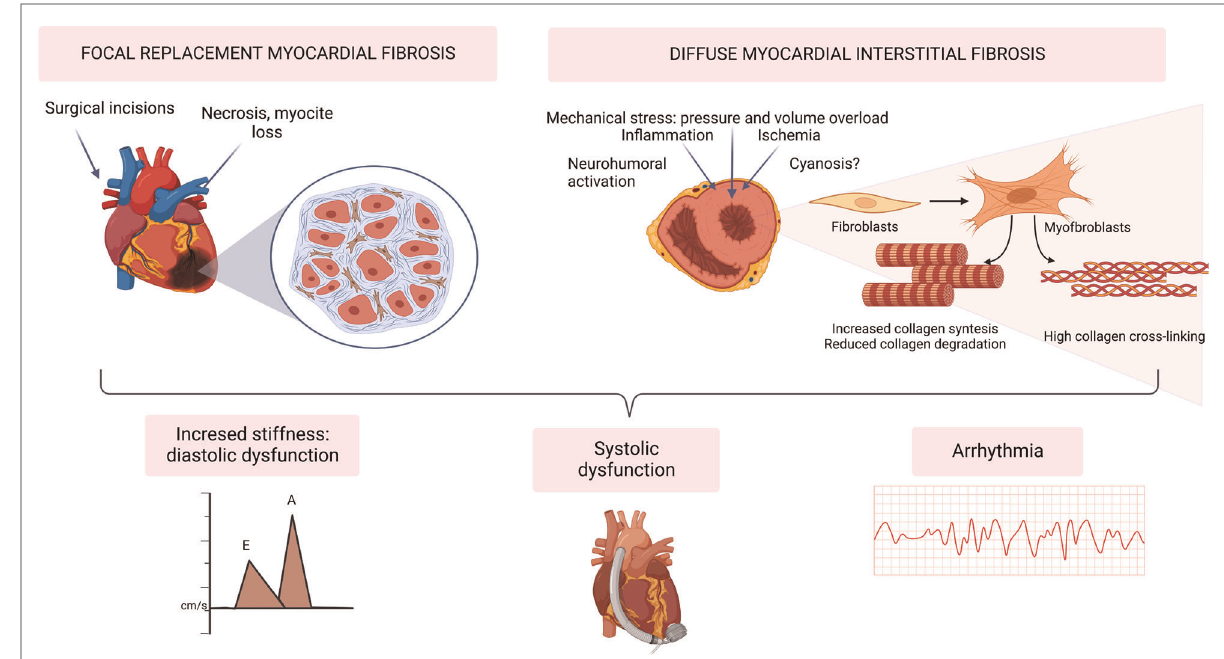
FIGURE 1 Myocardial fi brosis in the development of heart failure and arrhythmia in congenital heart disease. Created with BioRender.com.